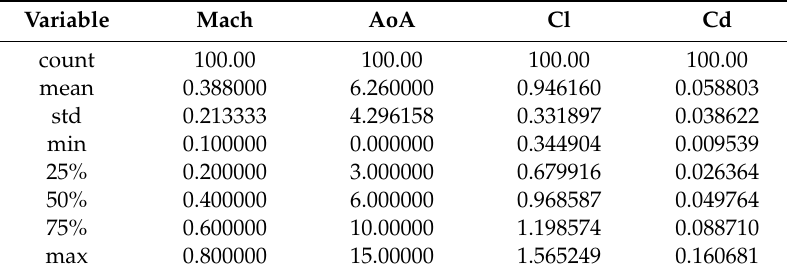
Table 5. Statistics of the aerodynamic database (DPW).